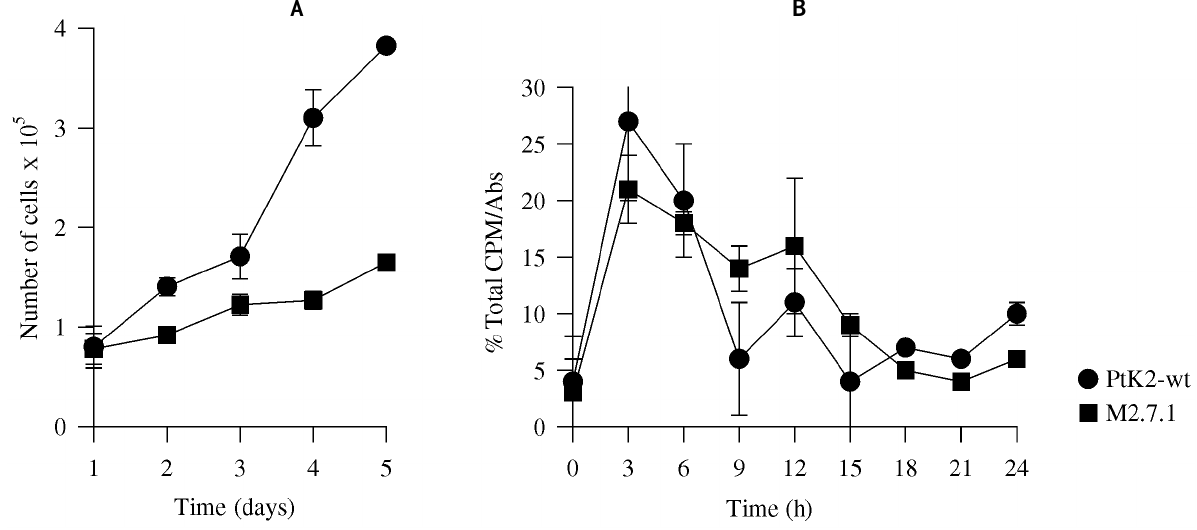
Figure 4 - Cell proliferation in PtK2 (circles) and M2.7.1 (squares) cells. A : Growth rate analysis - cells were plated (10 5 cells/plate) and cell number determined after indicated time. B : Synchronized cells as described in Material and Methods were pulse-labeled for 30 min and harvested at indicated times, for measure- ments of nucleotide incorporation in DNA during